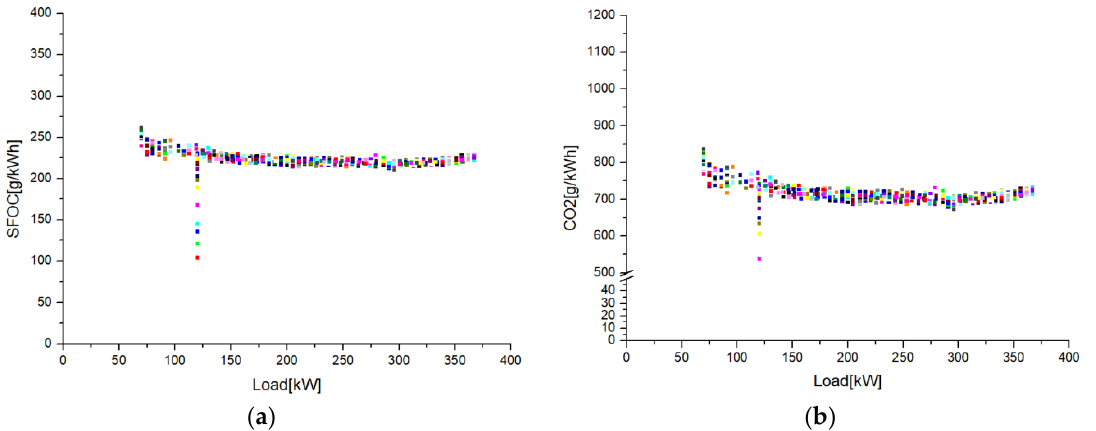
Figure 18. The results for the DC distribution system with variable speed mode; ( a ) SFOC, ( b ) CO 2 emission.